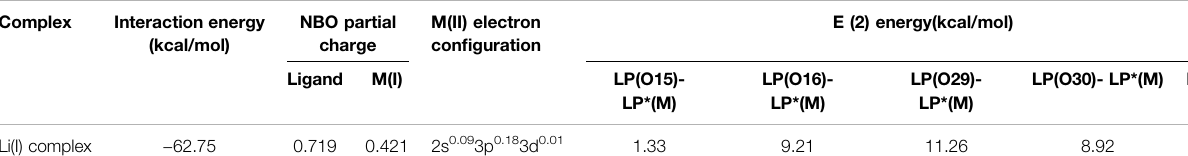
TABLE 4 | The calculated parameters for the complex. Complex